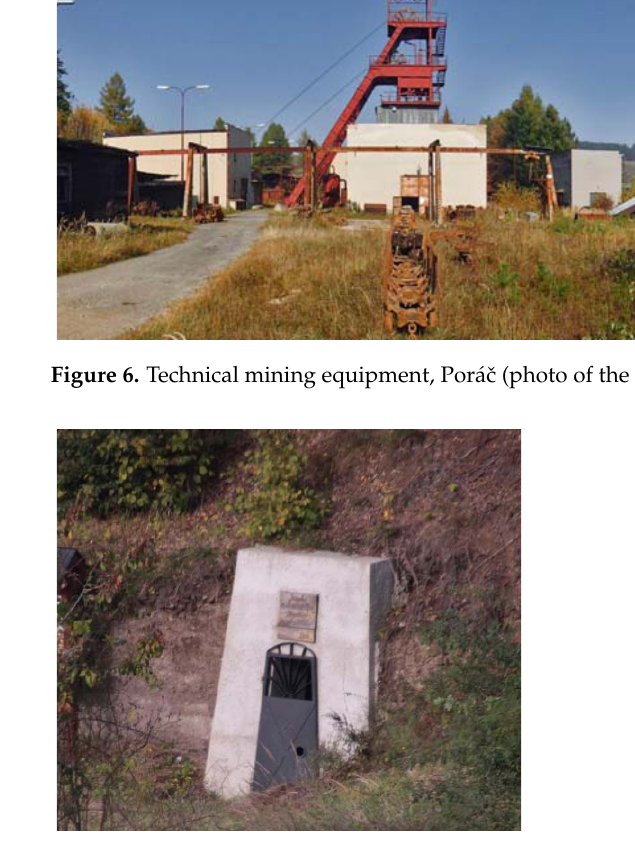
Figure 7. Mining artifact, Markušovce (photo Záveská, K.).